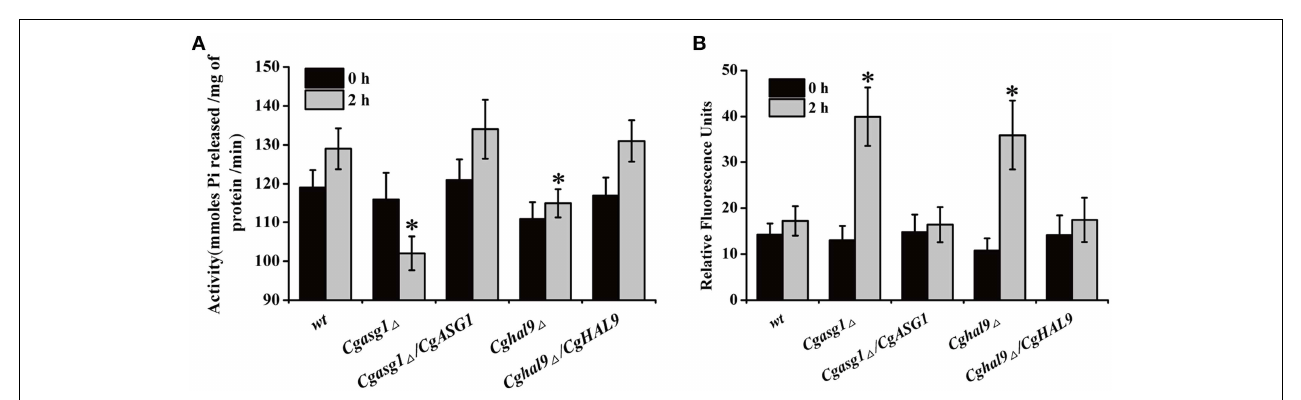
and Cghal9 △ strains were measured as described in the Materials and Methods Section. The above data are shown as the defined units at 0 and 2-h time points for incubation in YNB and YNB-pH 2.0 media. The means and standard deviations for three independent experiments are shown. Error bars represent standard deviations. ( * P < 0 . 05 compared to the corresponding wild-type control, as determined by t -test).